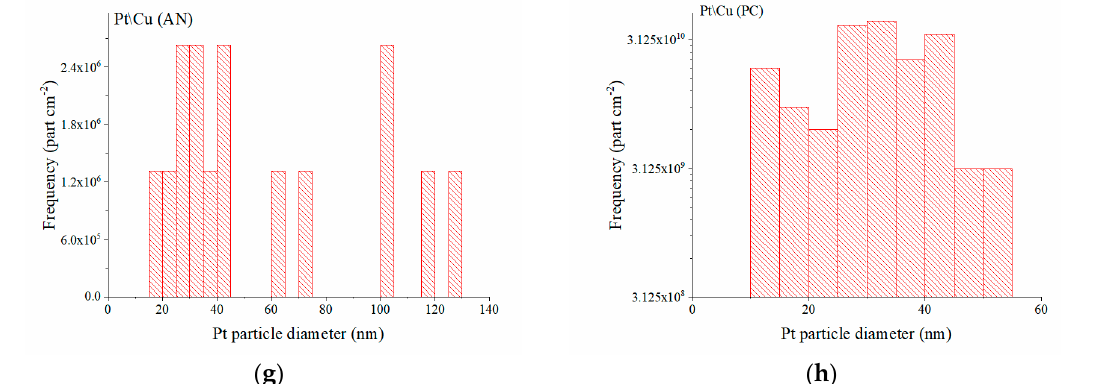
Figure 3. SEM images of the poly[Cu(Salen)](AN) ( a ) and poly[Cu(Salen)](PC) ( b ) polymer films, the mixed catalysts Pt / Cu (AN) ( c ) and Pt / Cu (PC) ( d ); EDX elemental analysis of the poly[Cu(Salen)] polymer film ( e ) and Pt / Cu (PC) mixed catalyst ( f ); distribution of the Pt particles sizes in the Pt / Cu (AN) ( g ) and Pt / Cu (PC) ( h ) catalysts. Table 1. Description of the samples, presented on Figure